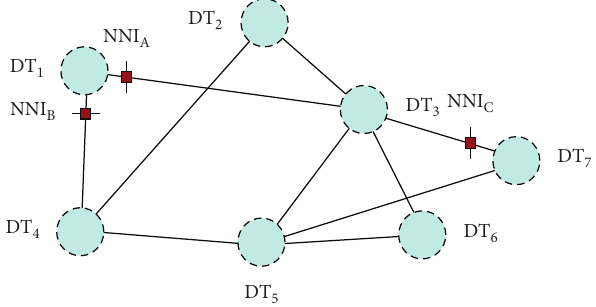
Figure 4: Network of the digital twins.